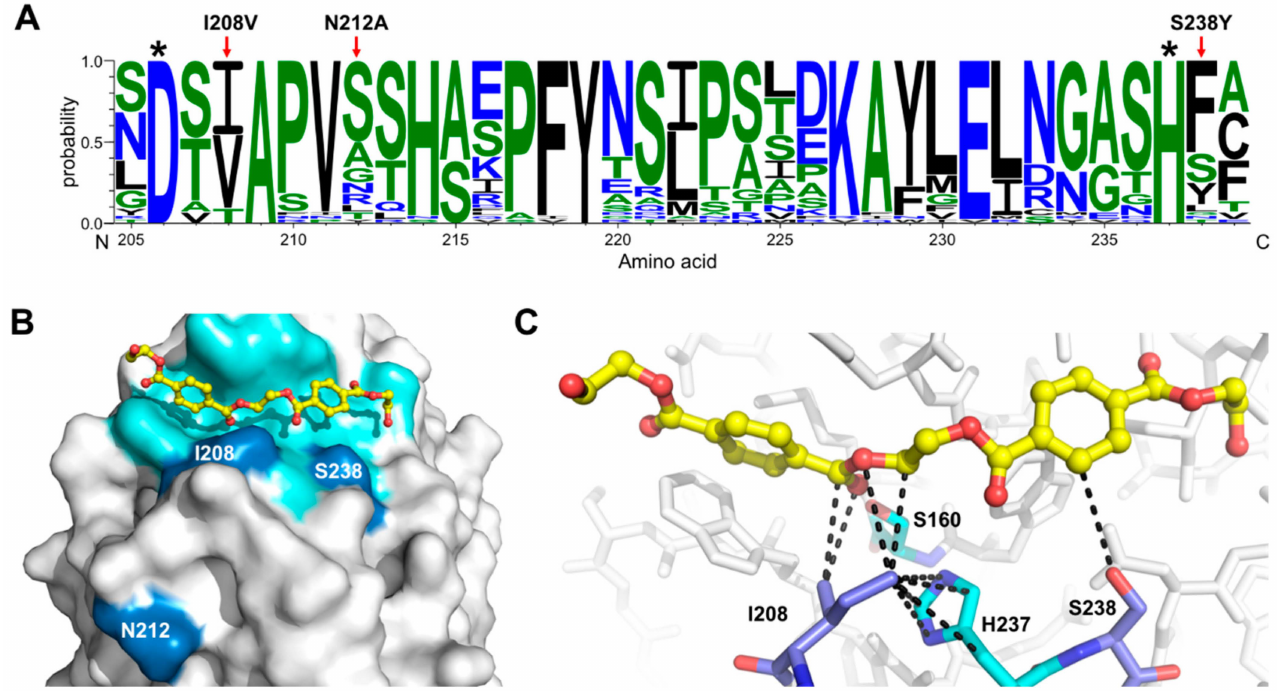
Figure 2. Single point mutations introduced in Is PETase. ( A ) Logo representation subalignment of Is PETase homologous enzymes. The * highlights the catalytic residues D206 and H237. ( B ) Connolly surface and PET modelled in Is PETase active site. The polypeptide, the residues forming contacts with the substrate and the mutations introduced in Is PETase are coloured light grey, cyan, and sky blue, respectively. ( C ) Snapshot of the MD simulation of the PET binding mode in the Is PETase active site. PET is represented in the ball and sticks model, while the protein amino acids are represented in the stick models. The carbon atoms are coloured yellow (PET), cyan (catalytic residues, S160 and H237), and sky blue (I208 and S238). Non-covalent interactions formed between the mutated residues, and the substrate or the polypeptide are represented by dashed